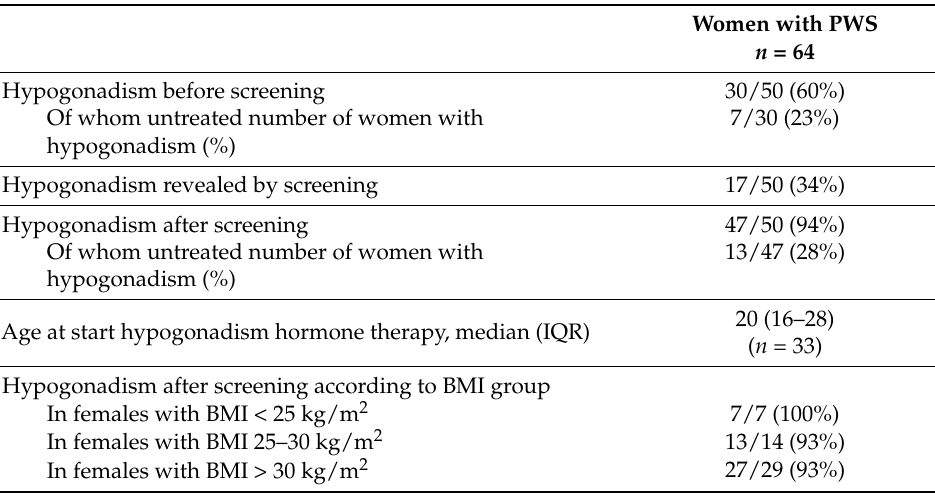
Table 2. Hypogonadism in women with Prader-Willi